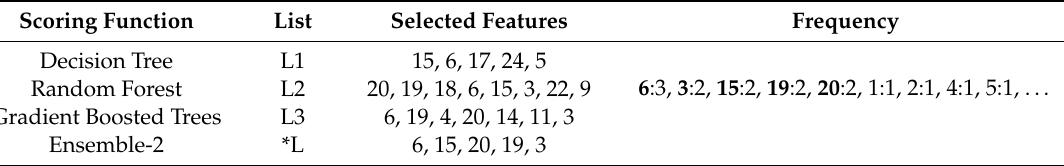
Table 12. Feature selected through ensemble-2.